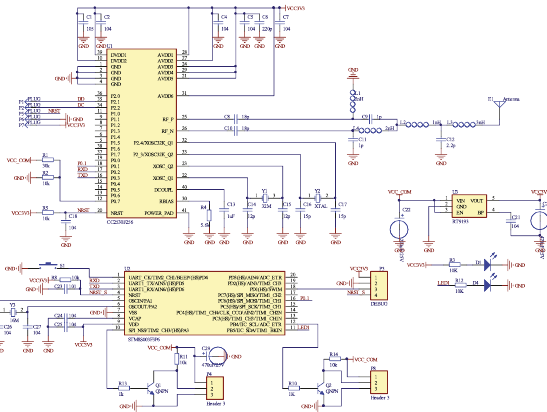
Figure 8: Circuit diagram of the slave control system.